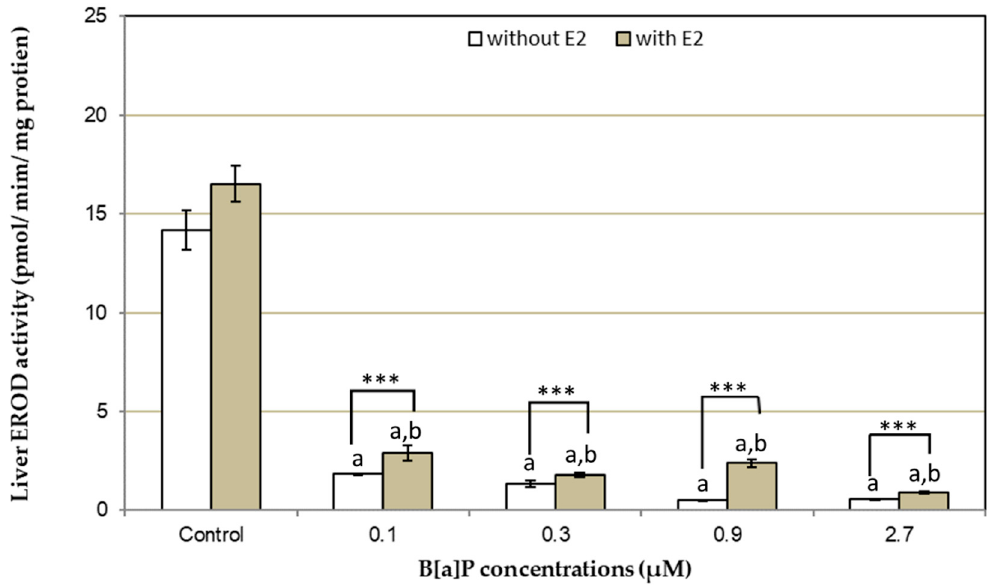
Figure 2. In vitro effects of benzo[a]pyrene (B[a]P) (0.1, 0.3, 0.9, and 2.7 µ M) without and with liver microsomal pre-exposure to 5.997 ng/mL of E 2 . Bars represent mean ± SE (n = 4). Asterisks (*) indicate differences between presence and absence of cortisol (* p < 0.05; ** p < 0.01; *** p < 0.001); the letters “a” and “b” indicate differences with control without E 2 , and with E 2 , respectively.